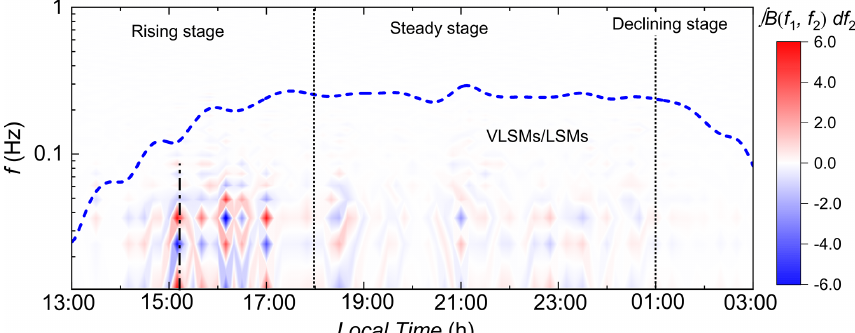
Figure 7. Two-dimensional contour map of the evolution of the integral bispectrum with time at the height 8.5m, where the height 8.5m corresponds to the logarithmic region center and the blue dashed line represents the cutoff frequency converted from the wavelength of λ = 0 . 3 δ associated with the LSMs and